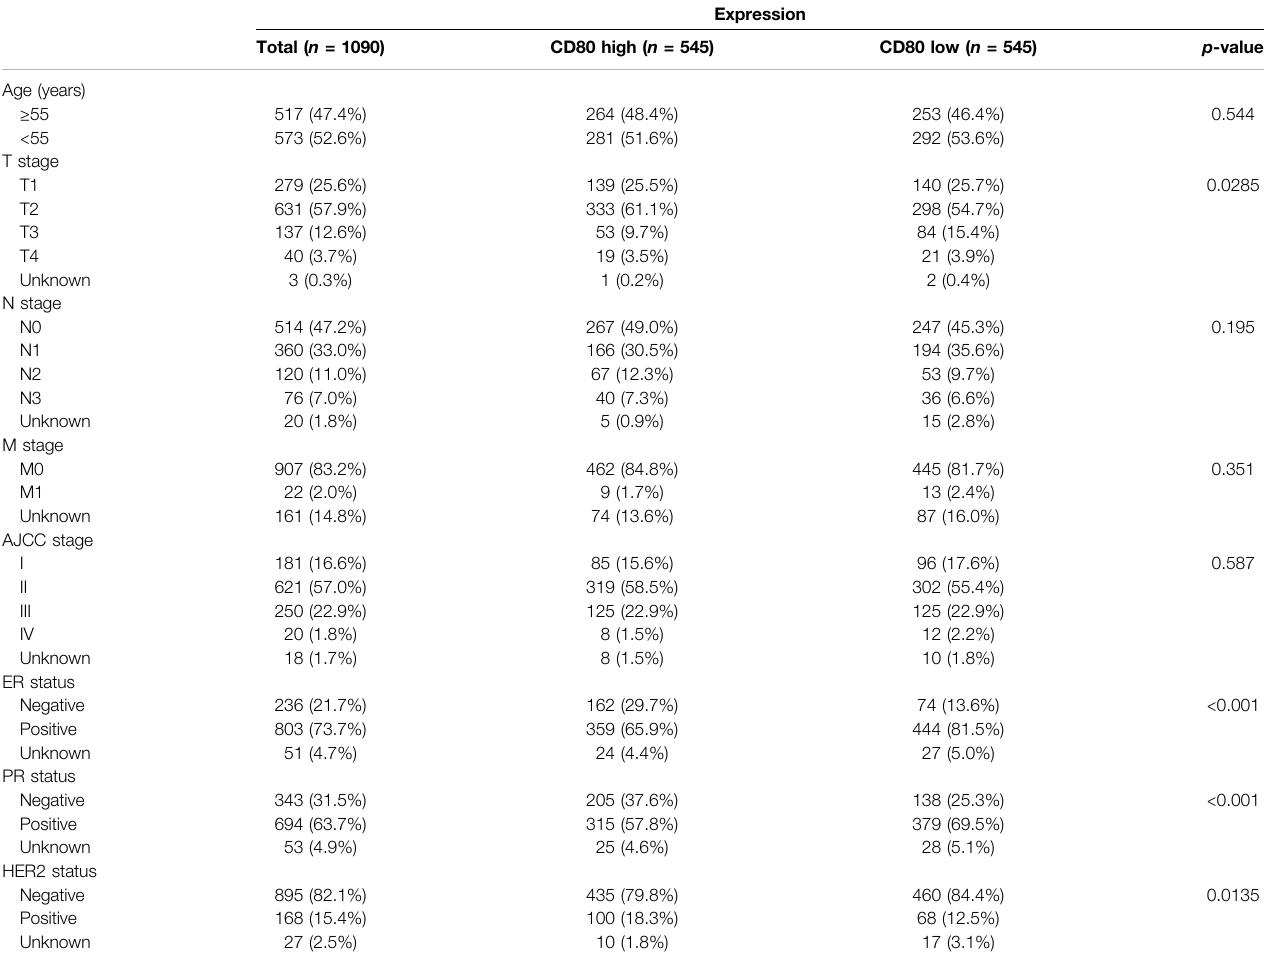
TABLE 1 | Association between the CD80 mRNA expression and clinicopathologic characteristics in TCGA cohort.